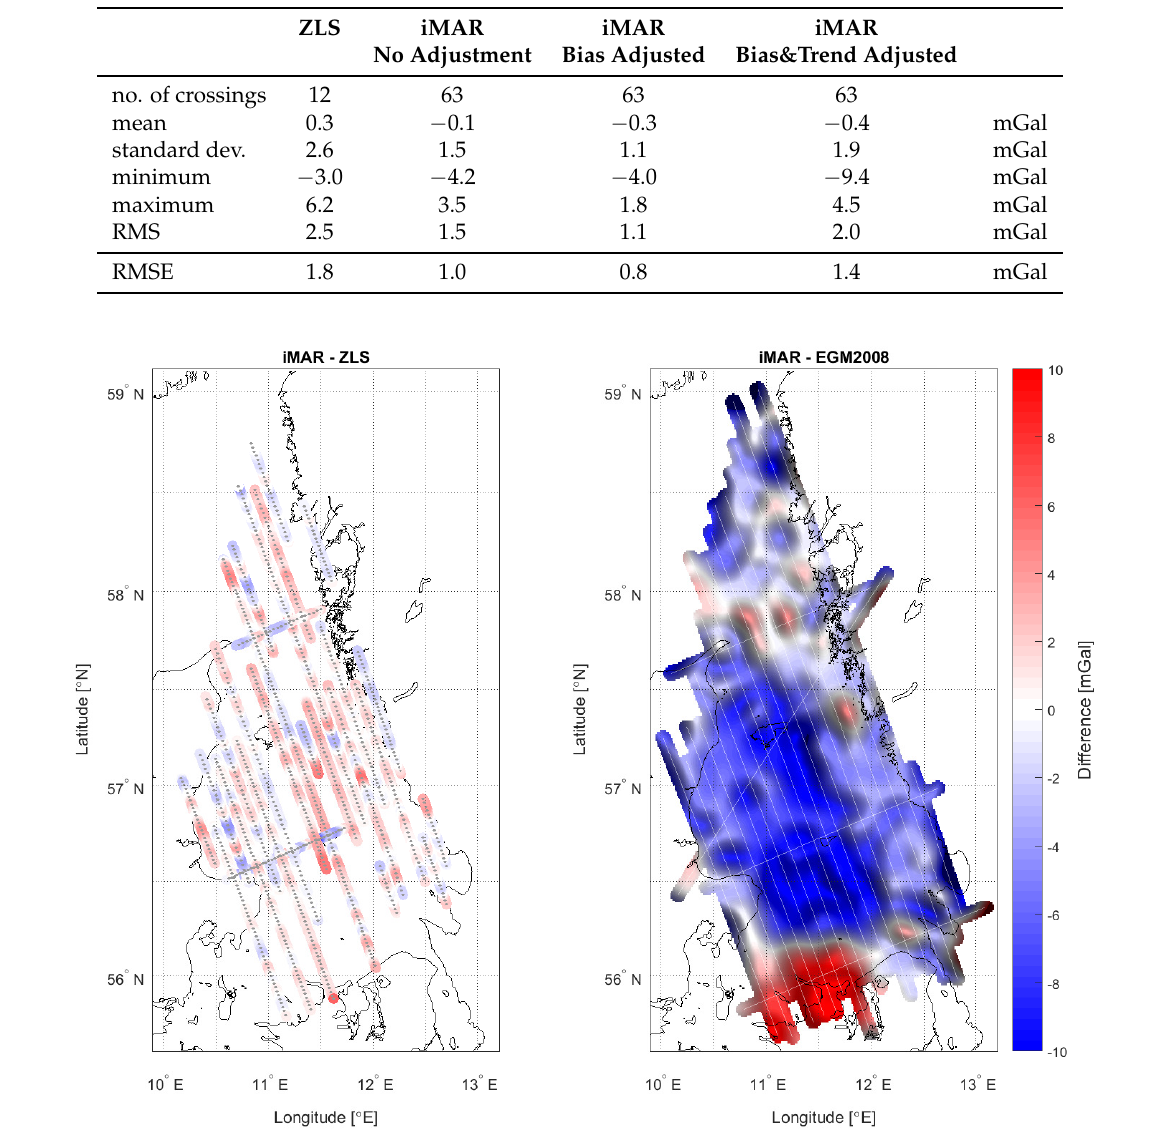
Table 3. Statistics from the difference between gravity estimates at cross-over locations.